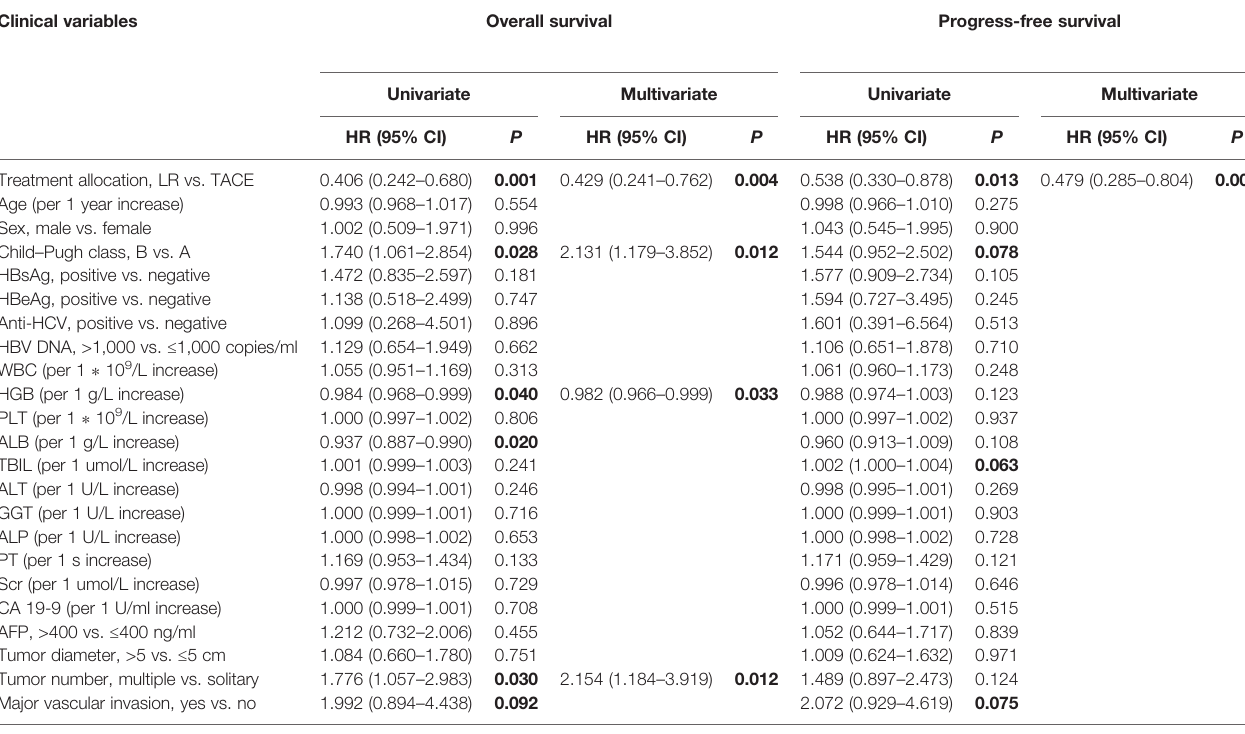
TABLE 3 | Prognostic factors for overall survival and Progress-free survival after PSM. Clinical variables Overall survival